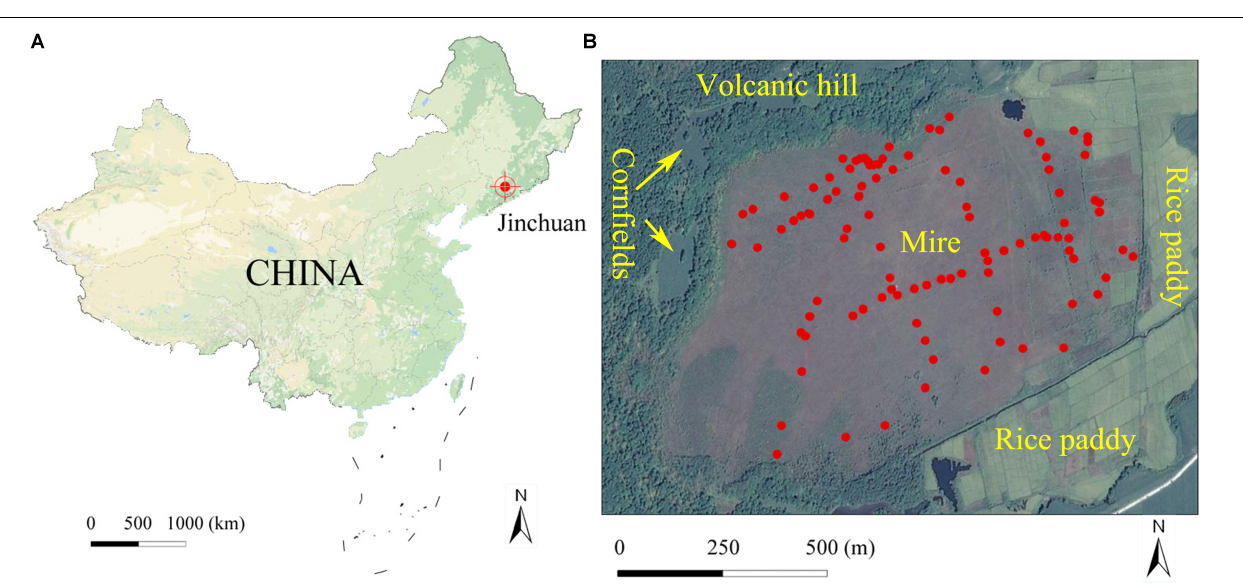
FIGURE 1 | Location of Jinchuan mire in China (A) and quadrat location in the mire (B) . The quadrats were marked with red points. The map image data comes from Google map.